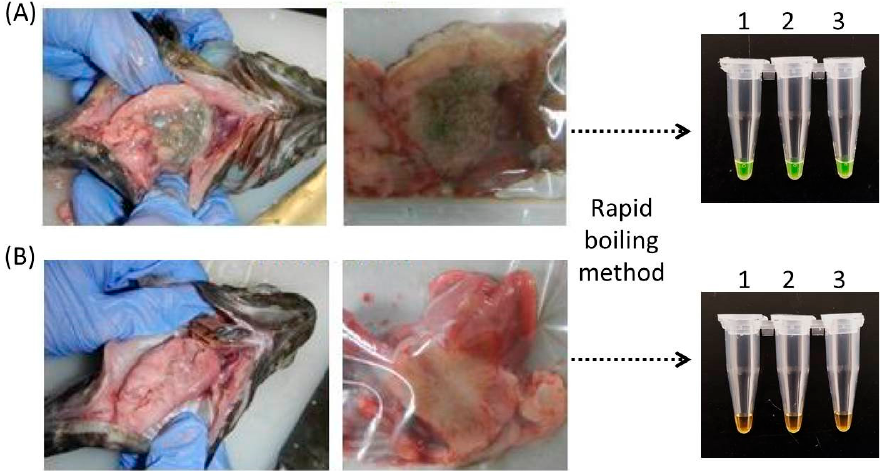
Figure 5. Evaluation of the improved LAMP-SYBR Green protocol on Vibrio harveyi infected grouper. ( A ) Sample of infected fish. ( B ) Sample of control non-infected fish. Tissue samples were obtained after 48 hrs of treatment, and the DNA template was prepared using the rapid-boiling method. The corresponding LAMP assay showed as being positive (green) for all three replicates, while the controls were negative